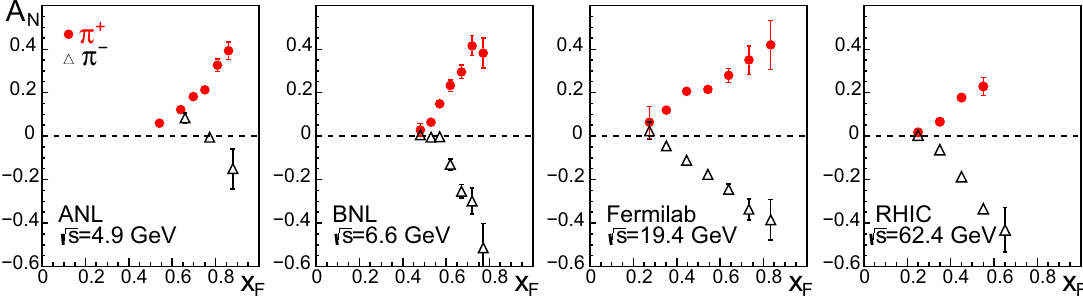
√ s , from [27] and measurements